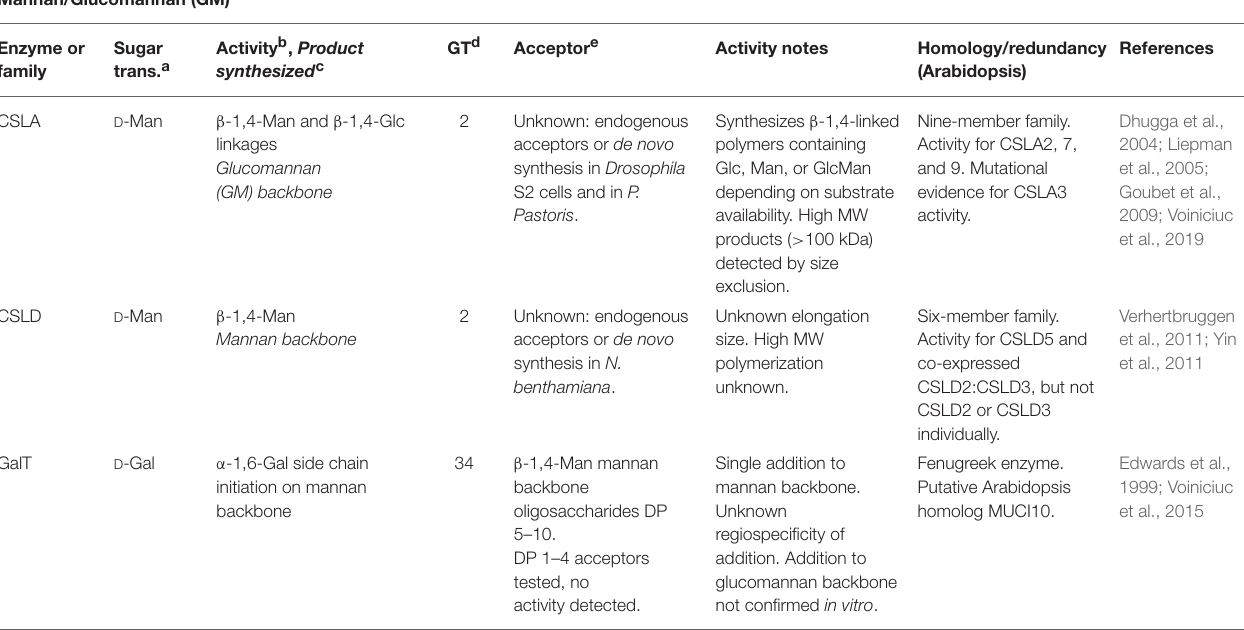
TABLE 3 | Heteromannan biosynthetic GTs of known function determined by heterologous expression. Mannan/Glucomannan